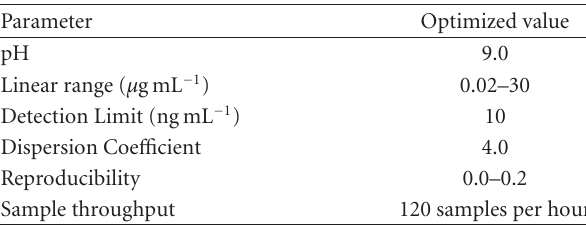
Table 2: Salient features of the proposed